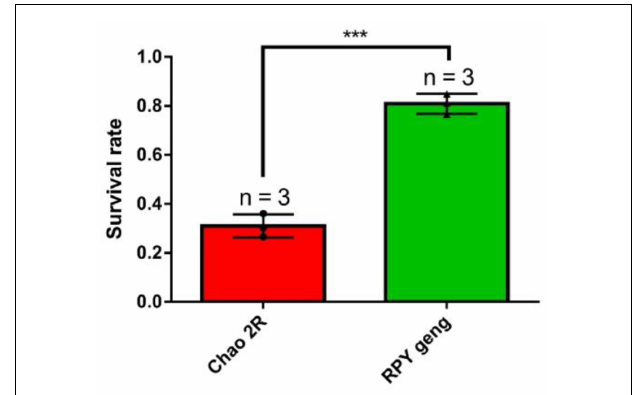
FIGURE 1 | The final survival rate of rice seedlings (Chao 2R and RPY geng) after 7 days of salt stress treatment and 7 days of recovery from three independent replicates. *** represented P value < 0.001. The bar value was generated from three independent biological replicates. Survival rate = number of surviving seedlings/total number of seedlings in each biological